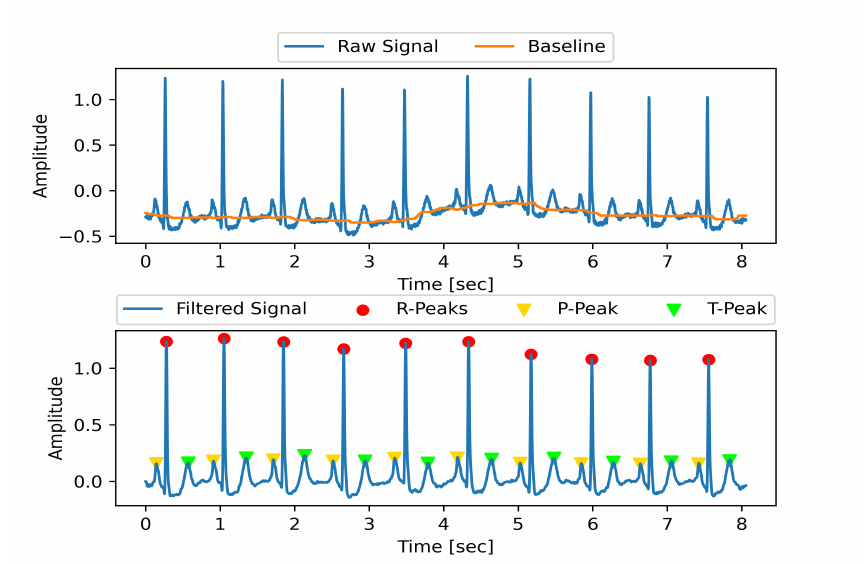
Figure 2. Pre-processing of